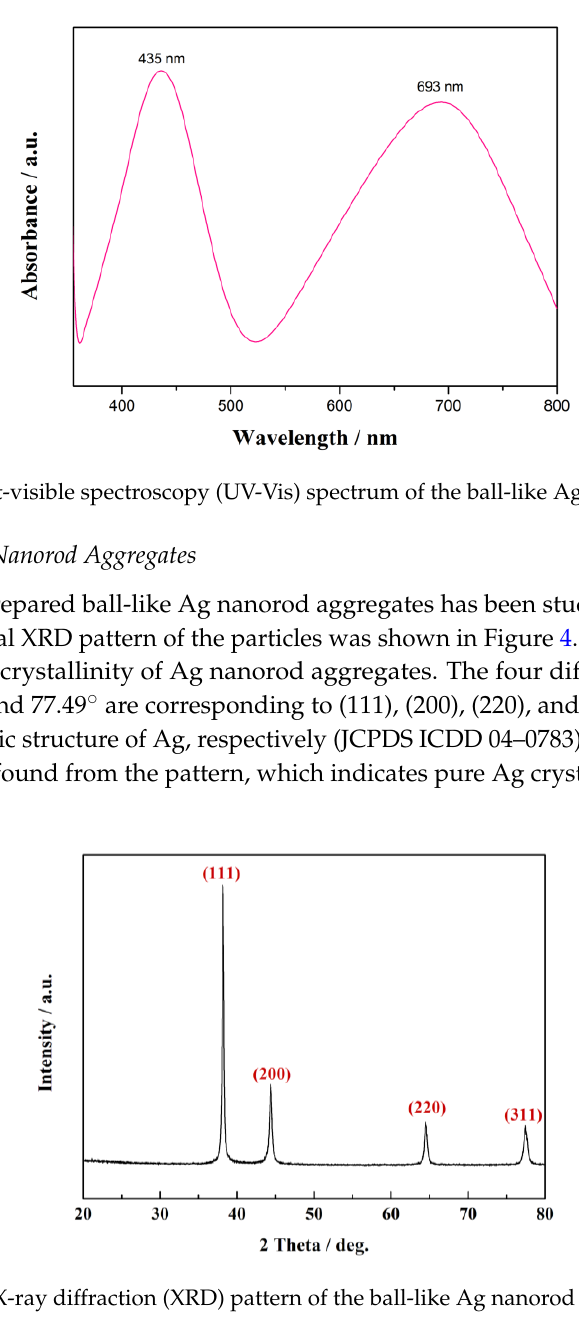
Figure 2. Transmission electron microscopy (TEM) ( a ) and high resolution TEM (HRTEM) ( b ) images of the ball-like Ag nanorod aggregates. Inset in ( b ) is the selected area electron diffraction (SEAD) pattern of Ag nanorod aggregates.